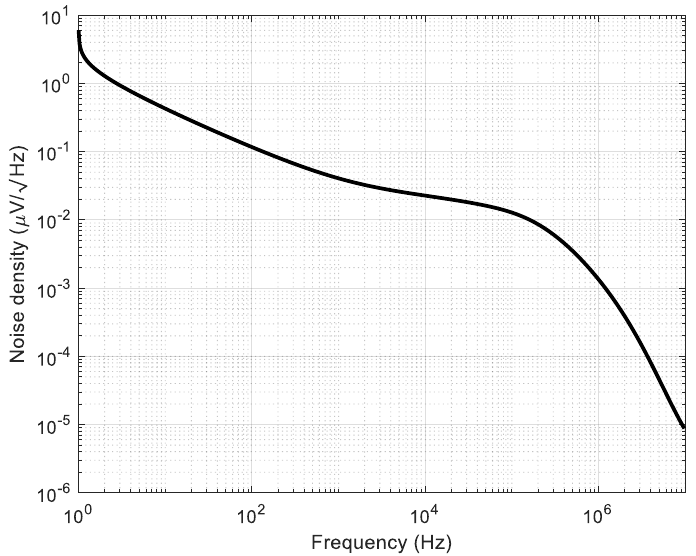
Figure 10. Output noise spectral density from 1 Hz to 10 MHz.